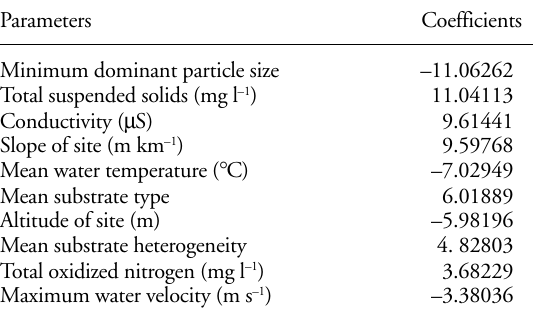
T able 4. Standardized canonical discriminant function coeffi- cients of environmental variables. Only the 10 most influencing parameters are shown and